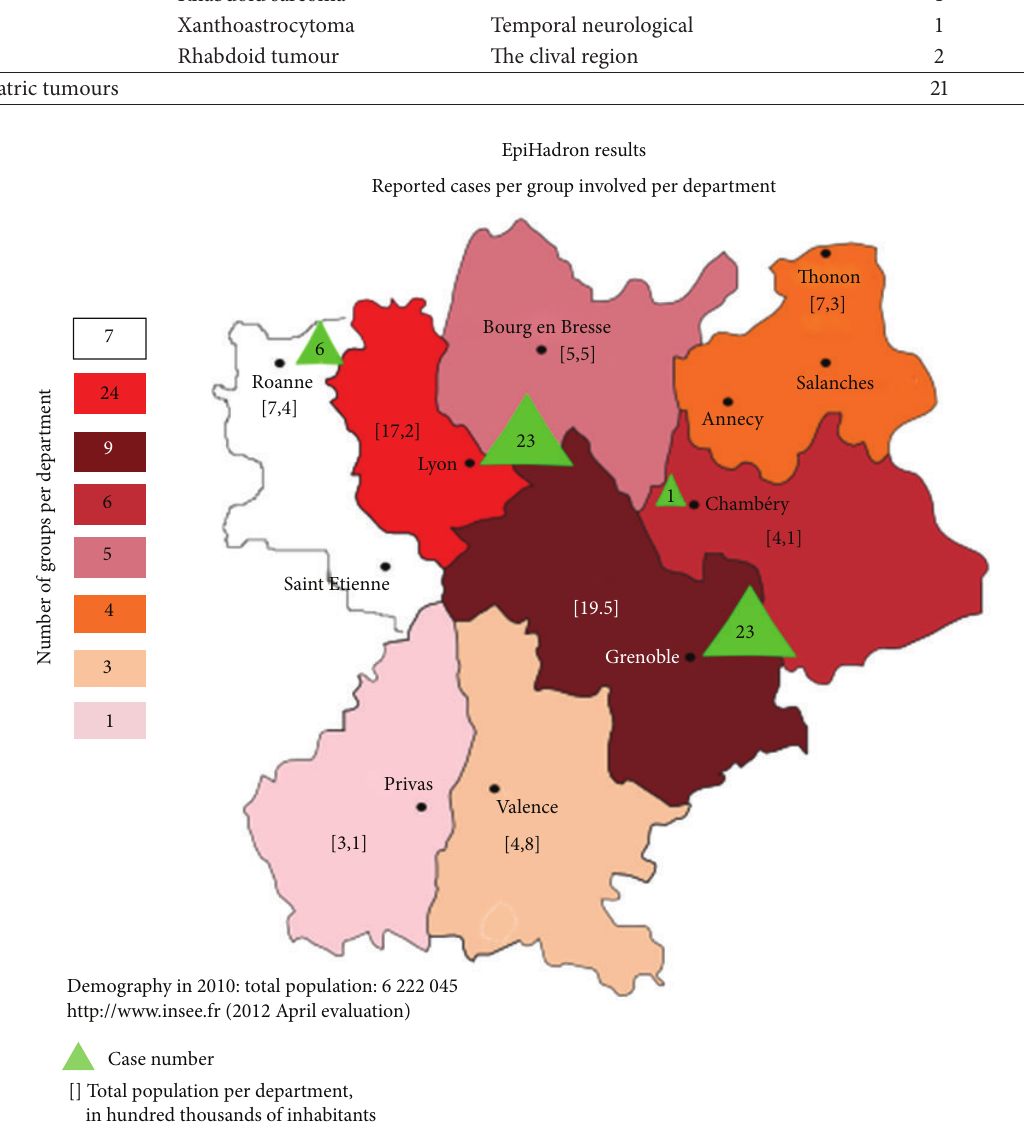
Figure 2: Results, EpiHadron study: number of cases identified relative to the number of groups involved in each